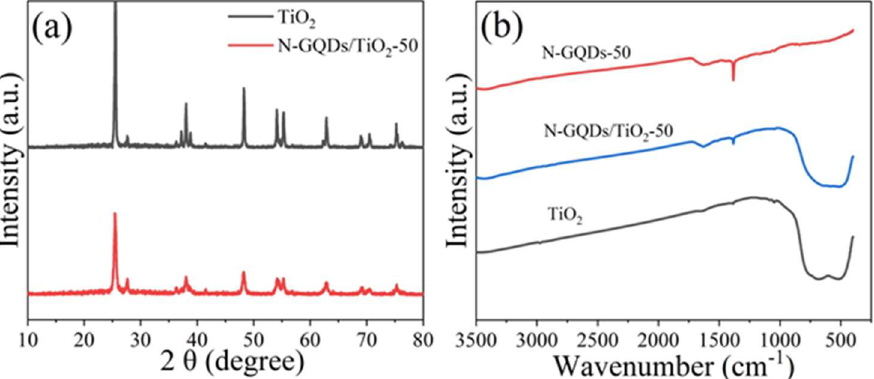
Figure 2. XRD pattern ( a ) of pure TiO 2 and N-GQDs/TiO 2 -50; FT-IR spectra ( b ) of pure TiO 2 , N-GQDs-50 and N-GQDs/TiO 2 -50 composites.